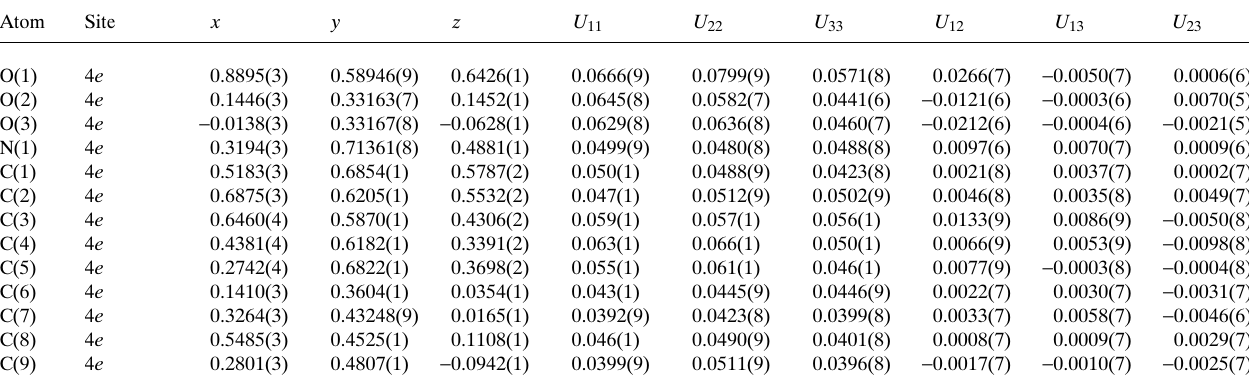
Table 3. Atomic coordinates and displacement parameters (in Å 2 )